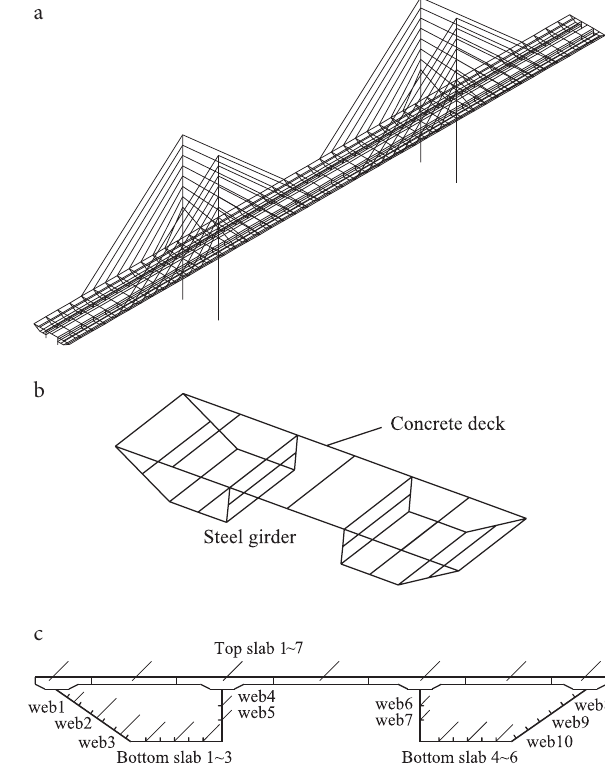
Fig. 3. A double-cell box section expressed by “plates” Fig. 4. A bridge at third cantilever construction state